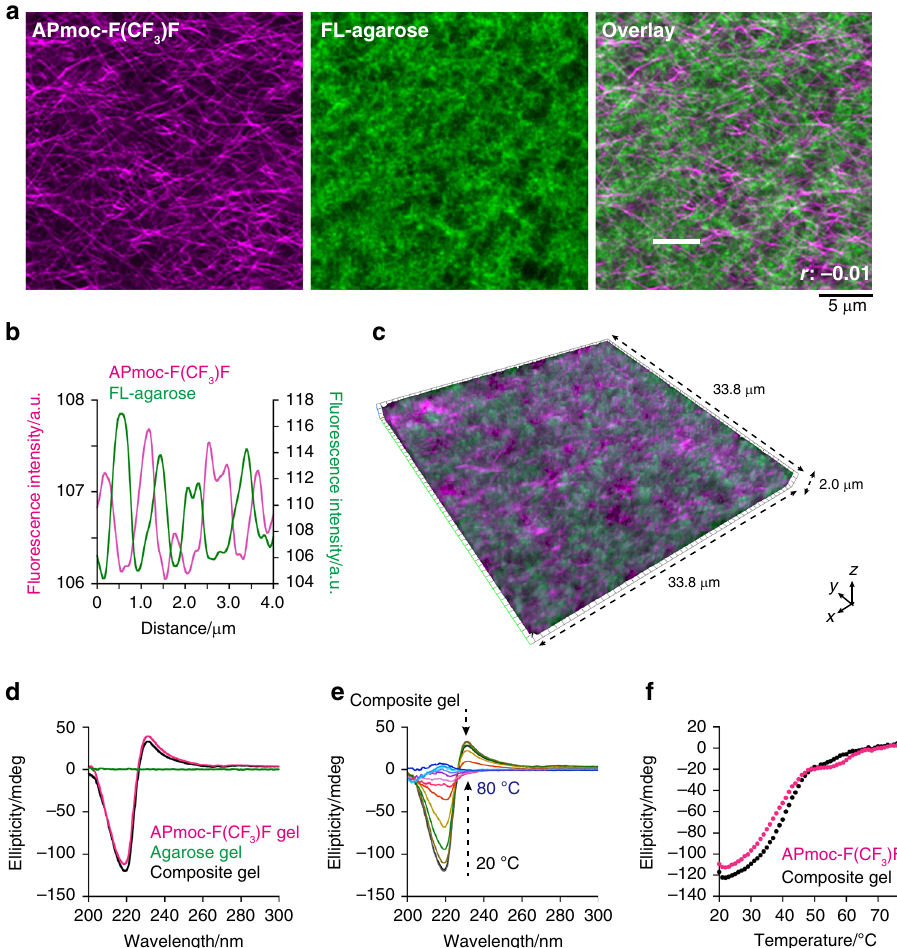
Fig. 4 Structural characterization of the supramolecular – agarose composite hydrogel. a , c High-resolution Airyscan CLSM images of the composite hydrogel composed of FL-agarose and APmoc-F(CF 3 )F stained with TMR-Gua . The staining selectivity was con fi rmed as shown in Supplementary Fig. 21. Left: TMR channel, middle: fl uorescein channel, right: the overlay image. Condition: [ APmoc-F(CF 3 )F ] = 0.6 wt%, [FL-agarose] = 0.5 wt%, [ TMR-Gua ] = 10 µ M, 100 mM HEPES, pH 8.0. r : Pearson ’ s correlation coef fi cient. b Line plot analysis of fl uorescent intensity along a white line shown in Fig. 4a. Magenta: APmoc-F(CF 3 )F , green: FL-agarose. d CD spectra of the (magenta) APmoc-F(CF 3 )F , (green) agarose, and (black) composite hydrogels. Temperature: 25 ° C. e Temperature-dependence CD spectra of the composite hydrogel. Temperature interval: 5 °C. f Plots of the CD intensity at 220 nm of the (magenta) APmoc-F(CF 3 )F and (black) composite hydrogels. Condition: [ APmoc-F(CF 3 )F ] = 0.6 wt%, [agarose] = 0.5 wt%, 100 mM HEPES, pH 8.0, optical length: 0.05